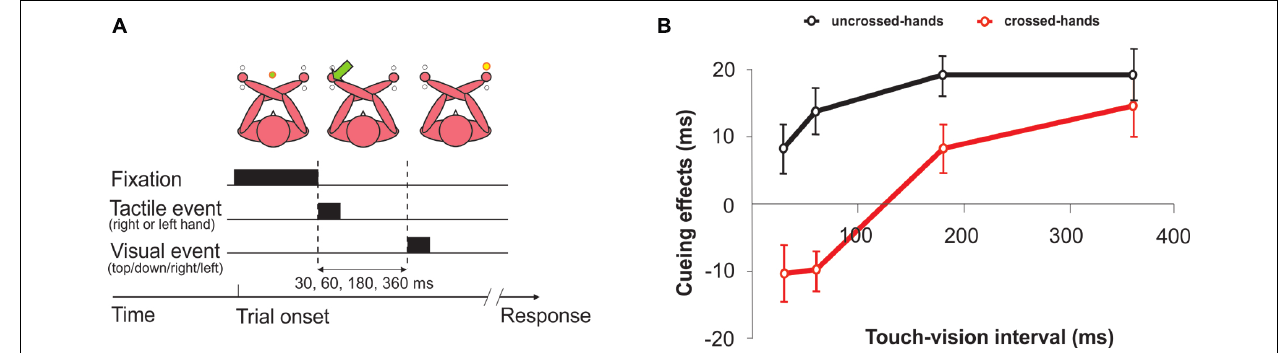
than 60 ms, spatial cueing effects appeared to be determined by somatotropic representations, as responses to the visual targets were faster in opposite cue-target side trials (anatomically congruent but spatially incongruent) than in same-side trials. The pattern reversed after about 200 ms, so that tactile cues produced a facilitation of targets presented at the same external location. No differences were found with uncrossed hands. Figure modified from Azañón and Soto-Faraco (2008a), with permission from